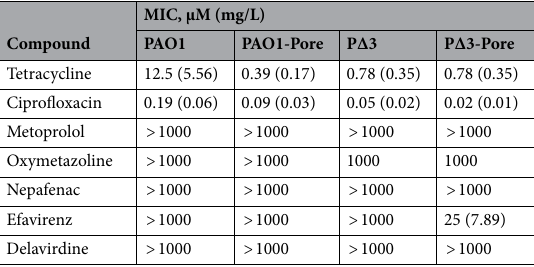
Table 1. Minimum inhibitory concentration of antibiotics and human therapeutics in four P. aeruginosa strains with varying permeability barriers.